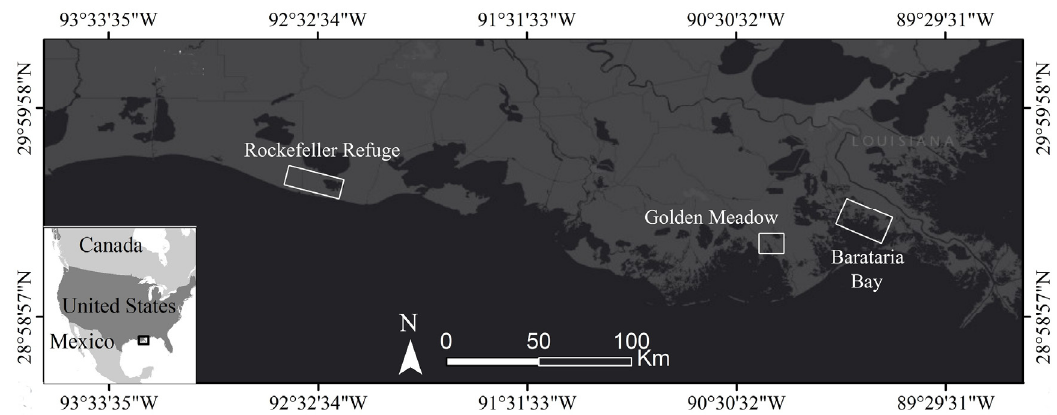
Figure 1. The coastal marsh region of Louisiana located in the north-central Gulf of Mexico. The boxes locate Barataria Bay, Golden Meadow, and Rockefeller Refuge study regions. Golden Meadow and Rockefeller Refuge S. alterniflor a field sites were occupied in 2010–2012 and Barataria Bay field sites in 2011 and 2012. NASA/UAVSAR PolSAR data and field data collections were coordinated. PolSAR collections in Barataria Bay occurred from 2009 to